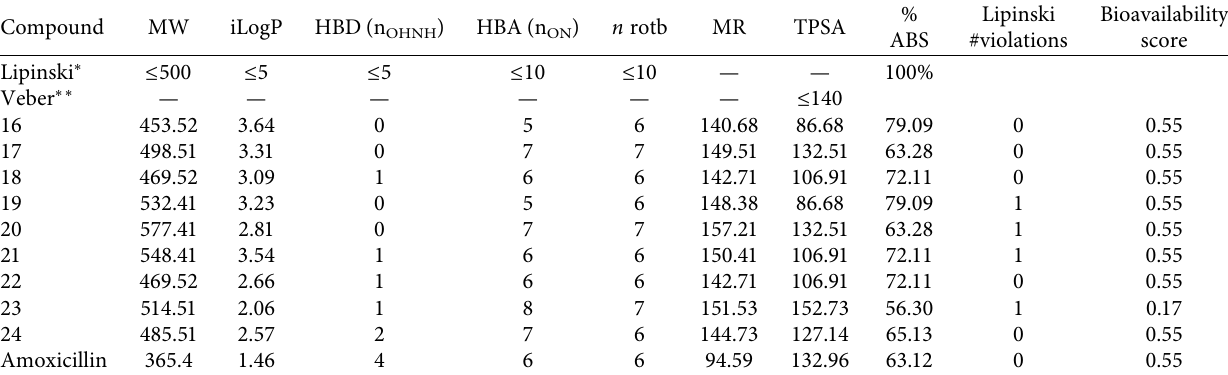
Lipinski Bioavailability score